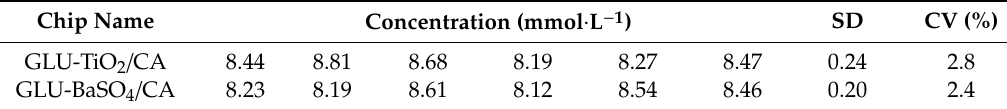
Table 4. Repeatability of TiO 2 / CA and BaSO 4 / CA detection chips.